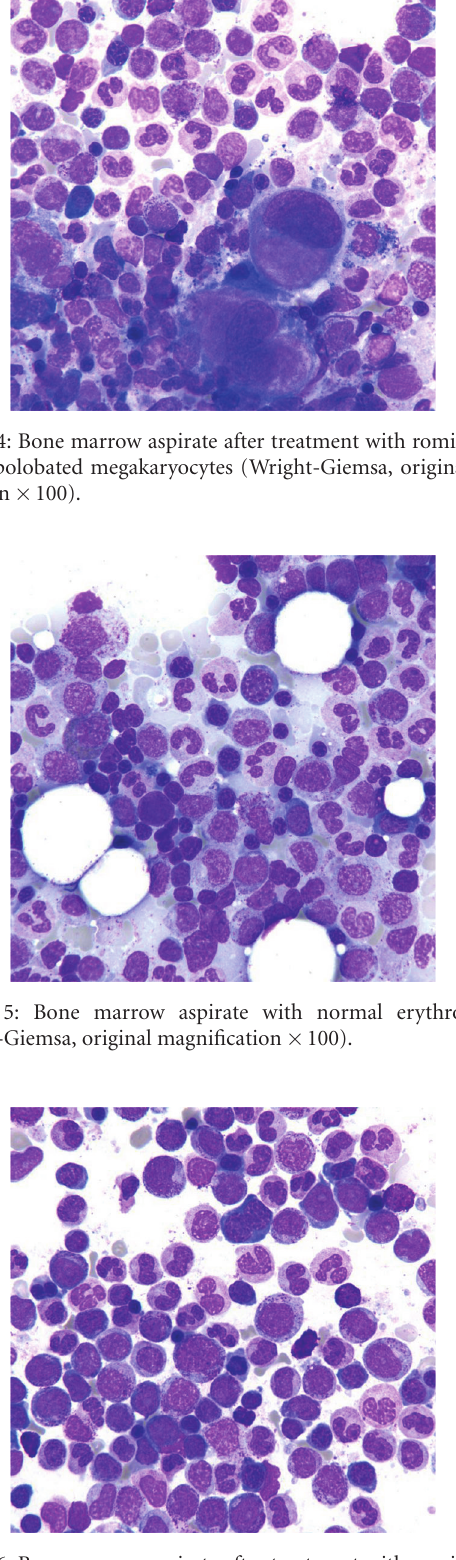
Figure 6: Bone marrow aspirate after treatment with romiplostim with erythrodysplasia (Note binucleation, irregular nuclear con- tours, and dyssynchronic maturation of the erythroid line) (Wright- Giemsa, original magnification × 1000).